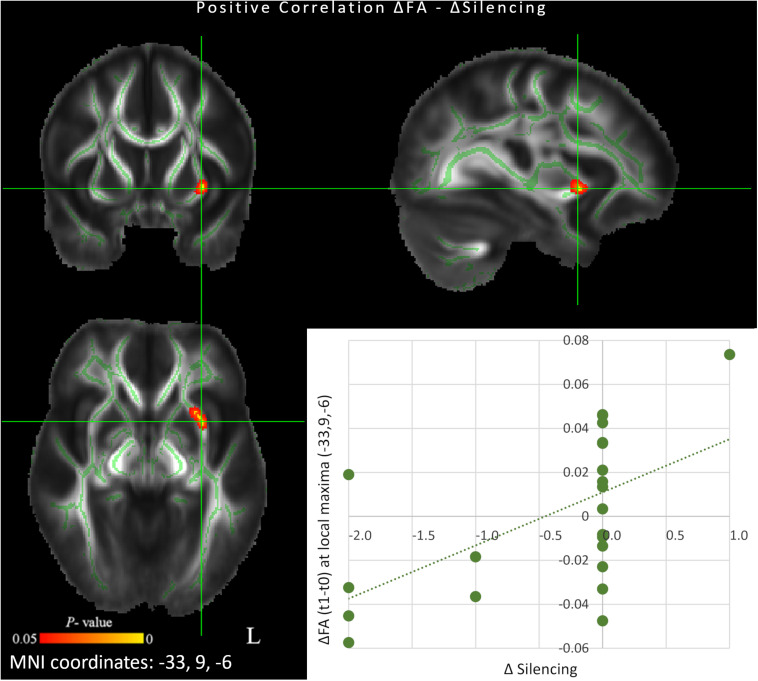
Scatterplot and results of voxel-wise correlation analysis between longitudinal changes in fractional anisotropy (FA) maps and concomitant changes in Silencing score (red-yellow color) between t0 and t1 (p < 0.05 FDR corrected). Only clusters showing a spatial extent of at least 30 voxels are reported. The study-specific FA skeleton, representing the centers of principal white matter tracts, is displayed in green, overlaid on the mean FA map. Anatomical localizations of peak MNI coordinates (mm) were established according to the JHU White-Matter Tractography and the JHU ICBM-DTI-81 White-Matter Labels atlases.